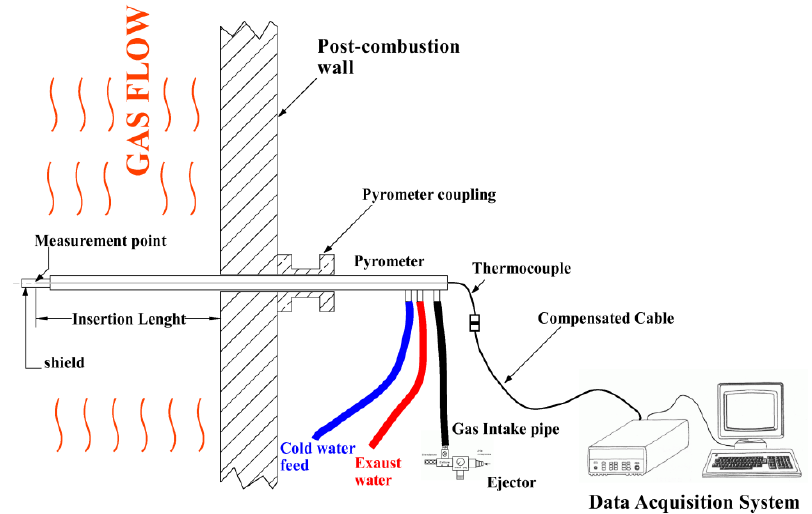
Figure 5. Lay out of a suction pyrometer with ancillary and data acquisition systems.